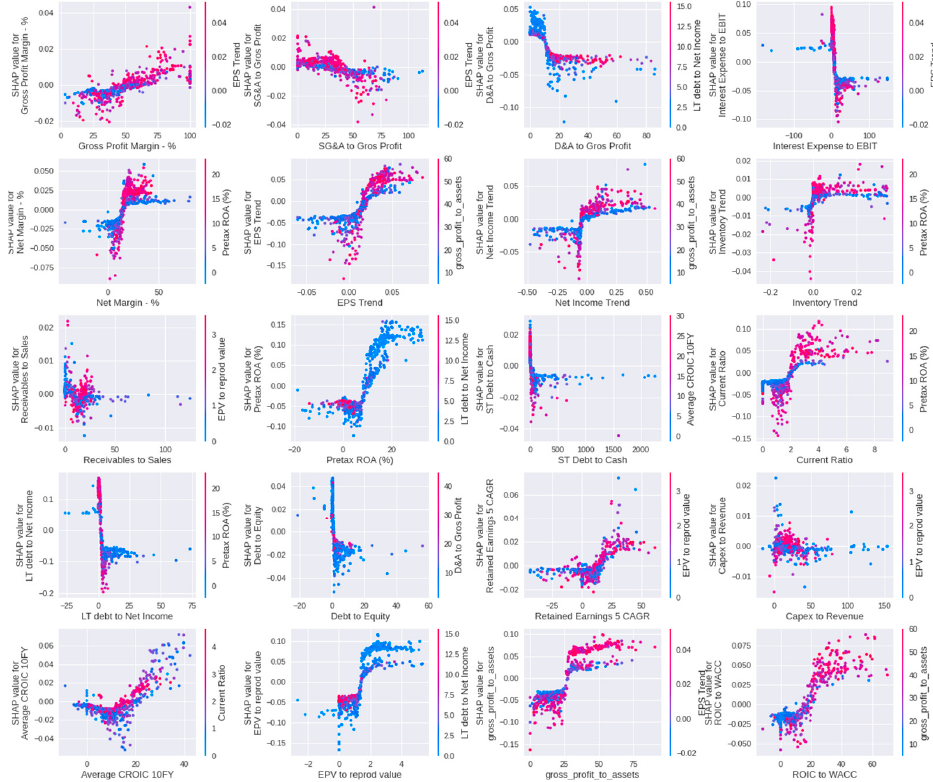
Figure A1. Dependence plot of companies with a wide moat.